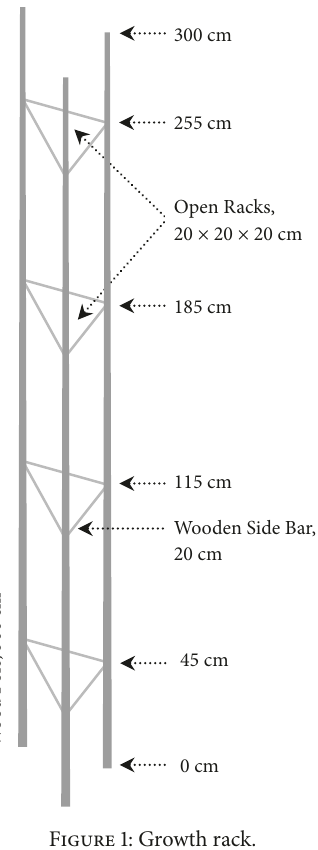
Figure 1: Growth